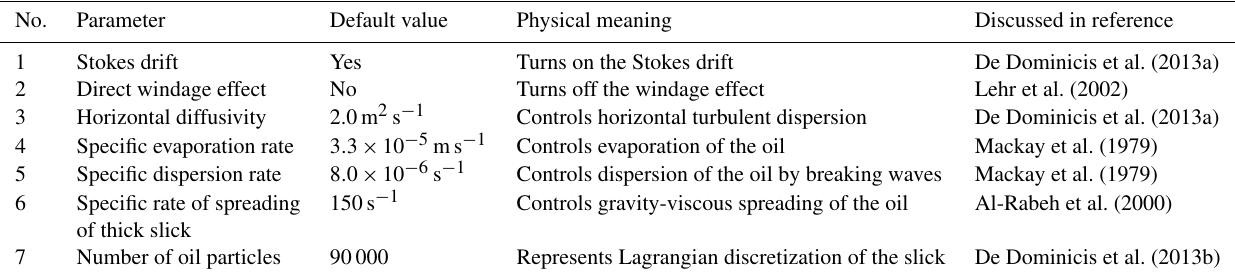
Table 1. Parameters for advanced user specification.